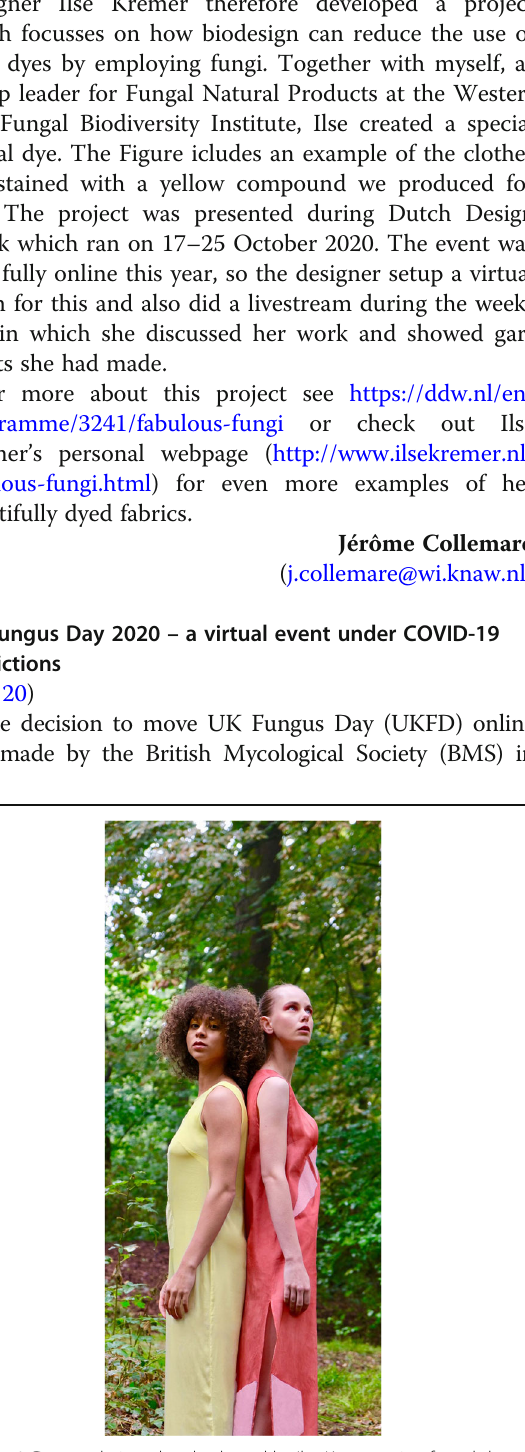
Fig. 19 Dresses designed and coloured by Ilse Kremer using fungal